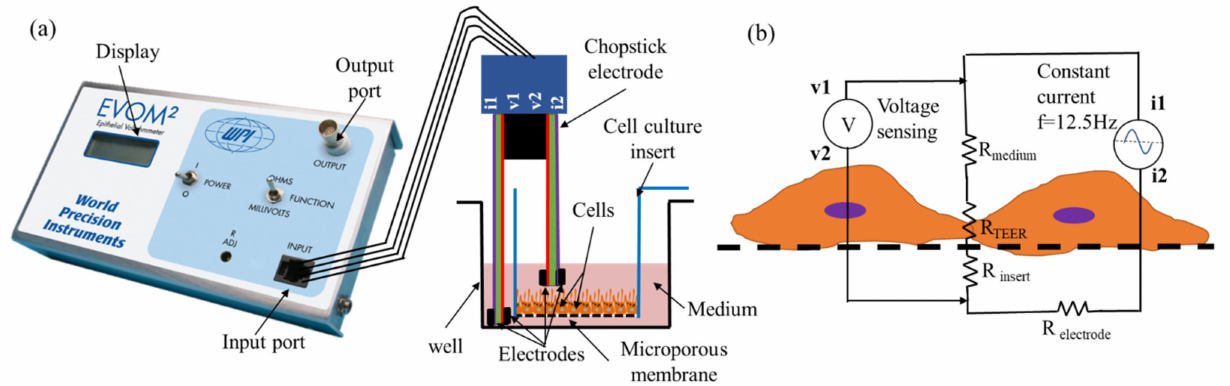
Figure 1. Transepithelial/endothelial electrical resistance (TEER) measurement using EVOM ® instrument. ( a ) A typical experiment setup for a four-electrode resistance measurement of a cellular monolayer in a transwell cell culture insert. ( b ) A simplified equivalent circuit diagram to model TEER measurement in a tissue culture transwell sample. EVOM ® supplies constant AC current through i1 & i2 electrodes, and measures resulting voltage drop through v1 & v2 electrodes to calculate total electrical resistance constituting of the cell layer R TEER , the cell culture medium R medium , the microporous membrane insert R insert , while eliminating resistance of the electrode medium interface R electrode